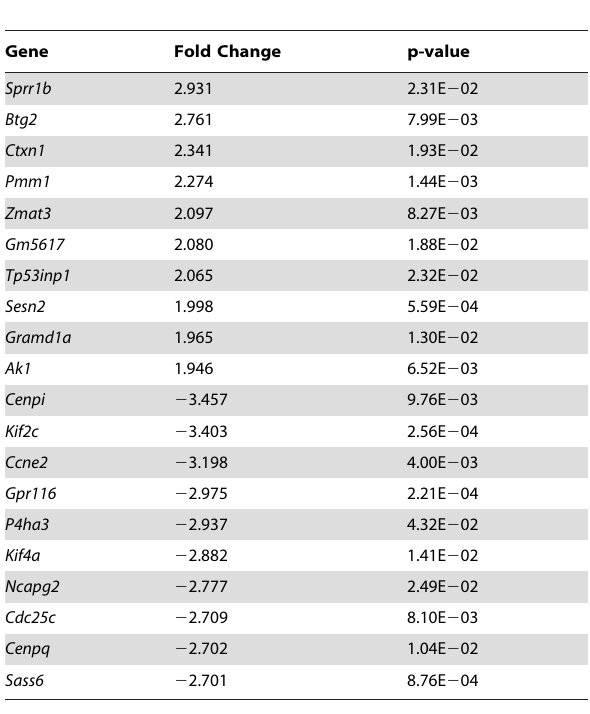
Table 1. Genes most highly up- or down-regulated following Arid4b